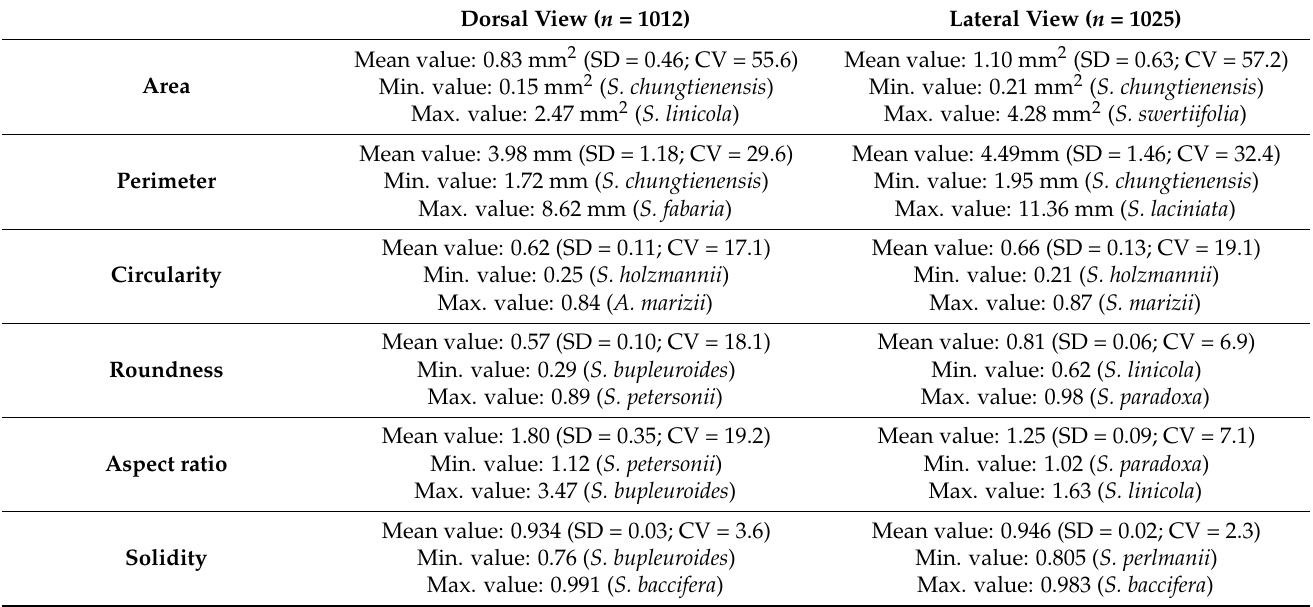
Table 1. Summary of the values obtained for the different geometric parameters from the seeds of Silene for both dorsal and lateral seed views. n is the total number of seeds measured. SD = Standard Deviation. CV = Coefficient of Variation.